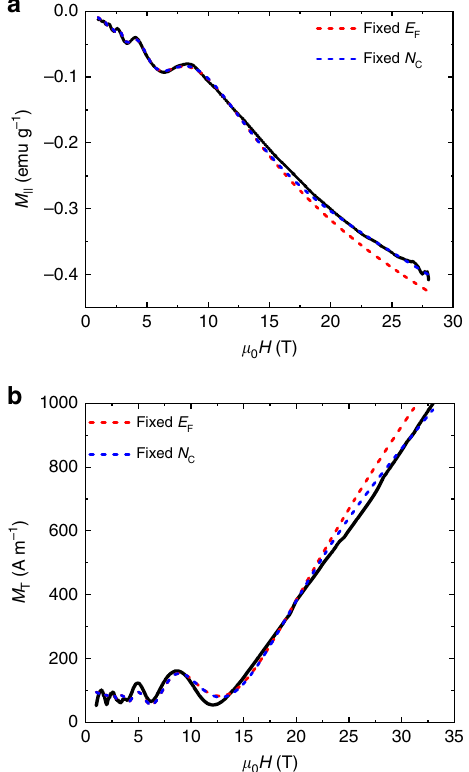
Fig. 4 Comparison between experiments and theory for the M || and M T of TaAs. a M || (black line) and b M T (black line). The blue dashed lines represent the theoretical results with the constraint of the fi xed E F in the full range of magnetic fi eld, while the red dashed lines represent the results with the constraint of the fi xed N c in strong fi